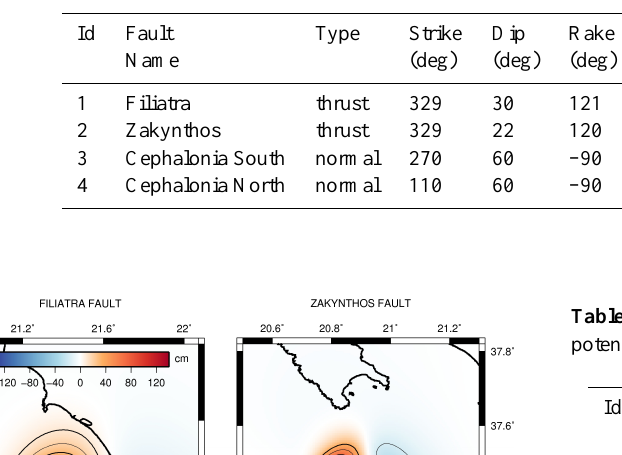
Table 2. Fault parameters of the selected potential tsunamigenic sources used for the numerical simulation (FAUST database, Stucchi et al., 2001; Papazachos and Papazachou, 1997).